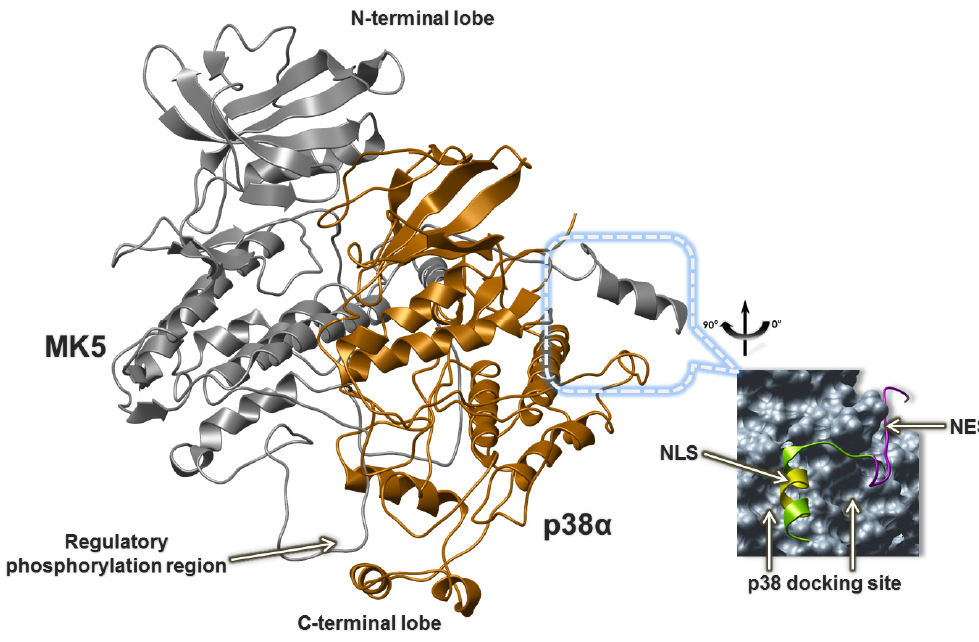
(NLS) of MK5. The MK5-p38 α complex indicates that NES and NLS are masked by the binding of p38 α . MK5 in grey ribbon and p38 α golden color